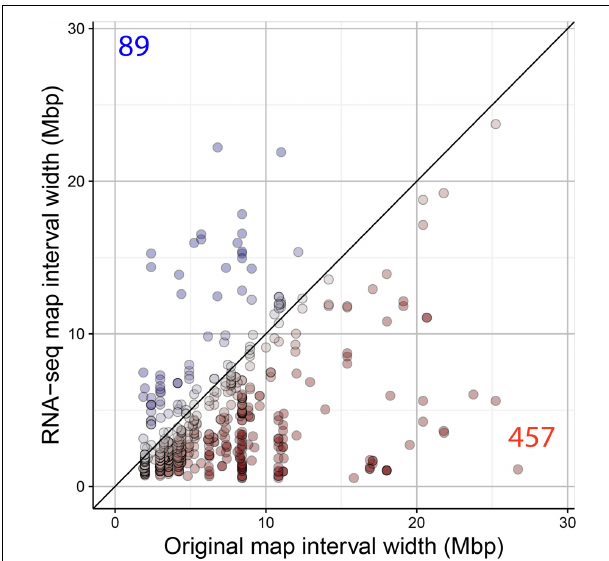
FIGURE 8 | Comparison of the QTL mapping resolution using the original and the RNA-seq map. CIs (in Mbp) of QTLs detected in the original and the RNA-seq map are shown. Red and blue dots/values indicate the number of significant QTLs (LOD > 3) with reduced and increased CI in the RNA-seq map, respectively.